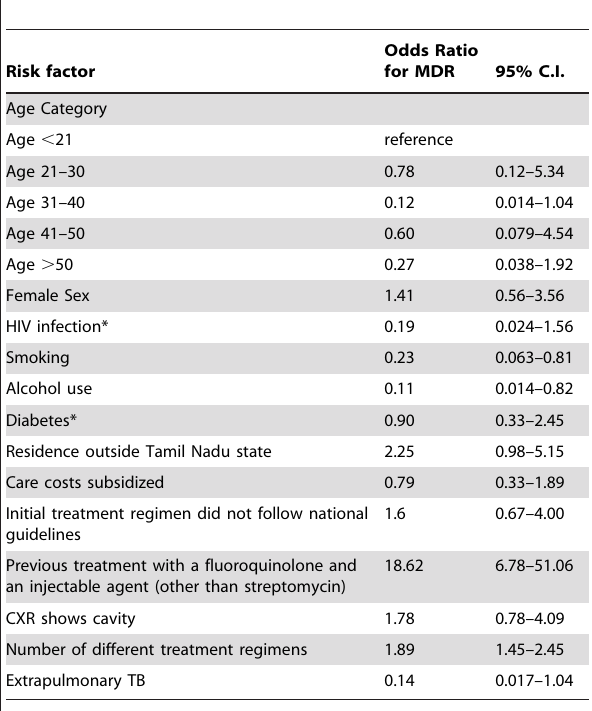
Table 2. Bivariate Analysis: Risk factors for